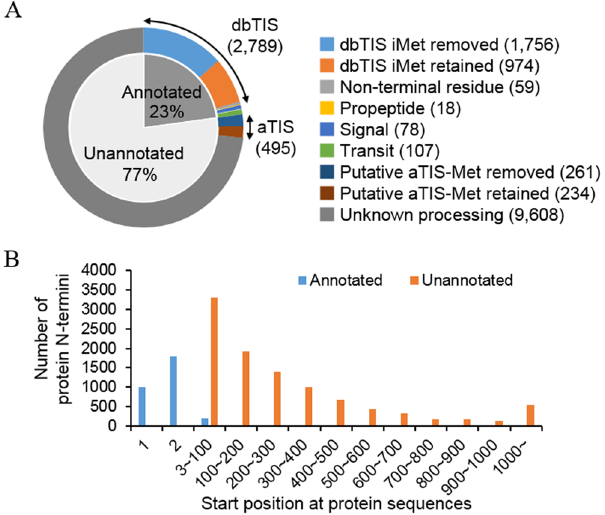
Figure 3. Classification of discovered N-termini and their positions along the protein sequences. ( A ) Classification of protein N-termini. dbTIS: UniProtKB-annotated translation initiation site; Non-terminal residue: protein N-termini starting with the first, but not methionine residue in the UniProtKB database; Propeptide/Signal/Transit: protein N-termini arising after removal of pro-, signal-, or transit-peptide; putative aTIS: putative alternative translation initiation site. ( B ) A number of protein N-termini identified according to their positions along the protein